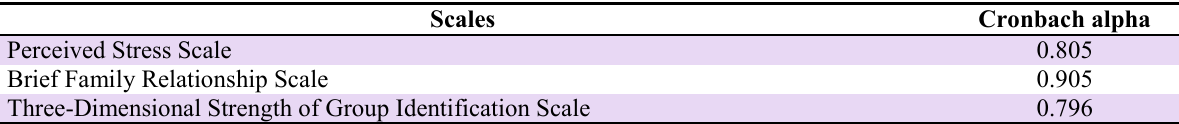
Table 3. The Cronbach alpha coefficients for the